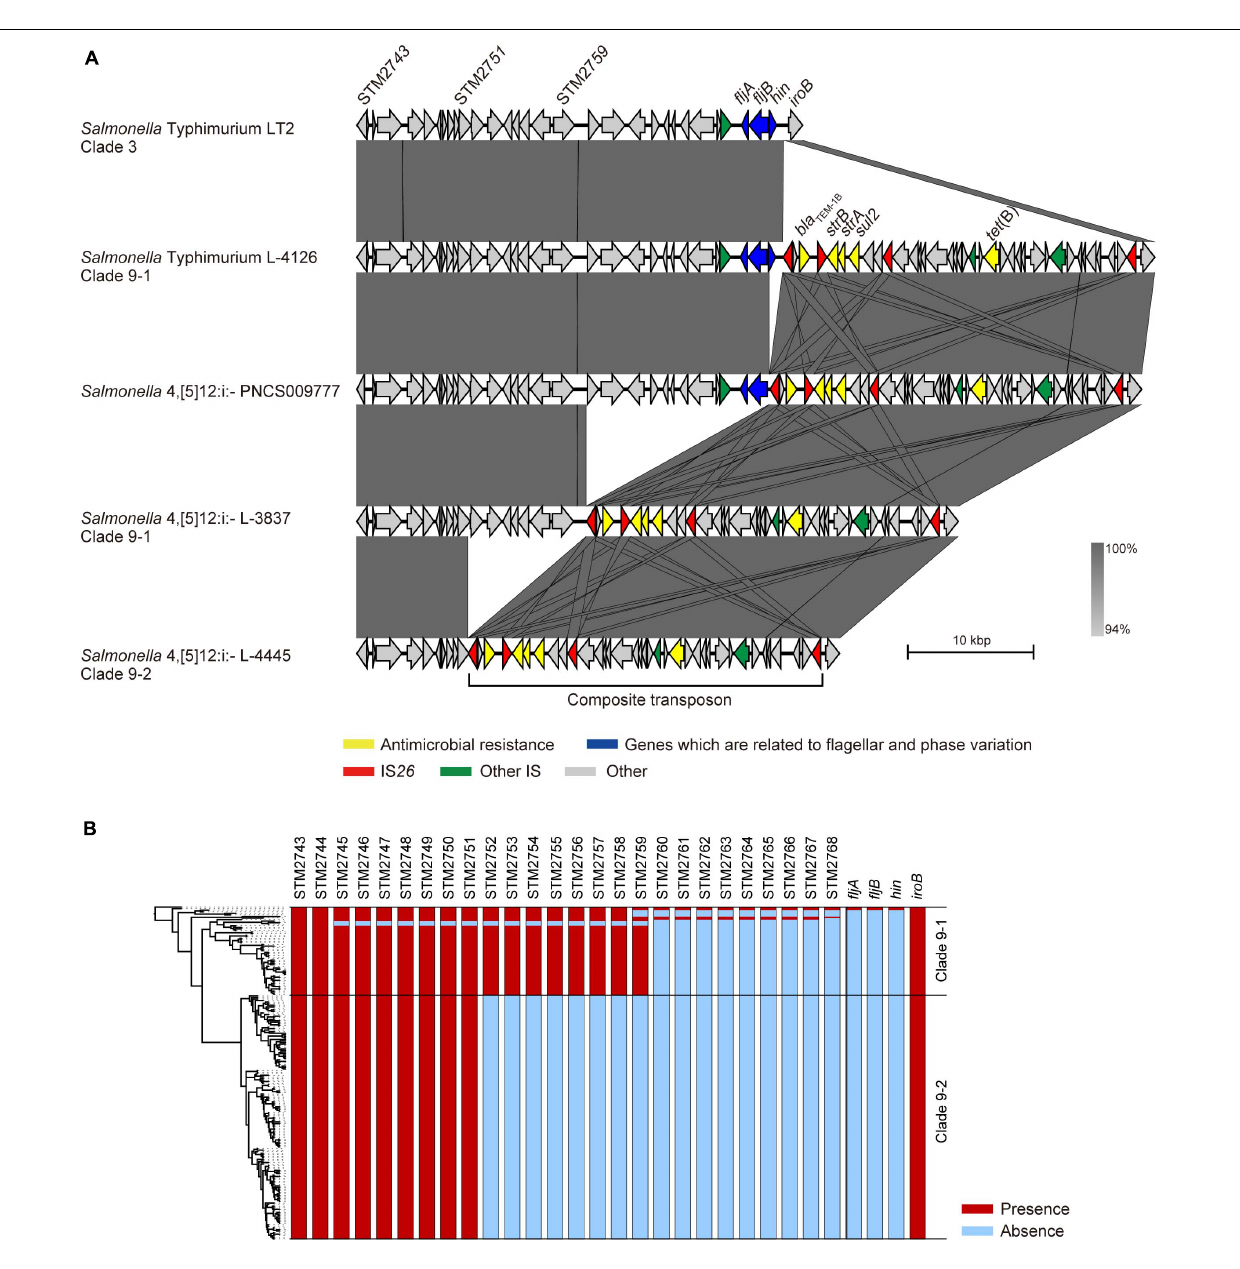
FIGURE 2 | Comparison of the flanking regions of fljB . (A) Comparison of the genetic structures among non-clade 9 Salmonella Typhimurium, clade 9–1 Salmonella Typhimurium, clade 9–1 Salmonella 4,[5],12:i:-, and clade 9–2 Salmonella 4,[5],12:i:-. (B) Gene repertoires located between the STM2743 and iroB genes are shown beside the phylogenetic tree represented in Figure 1